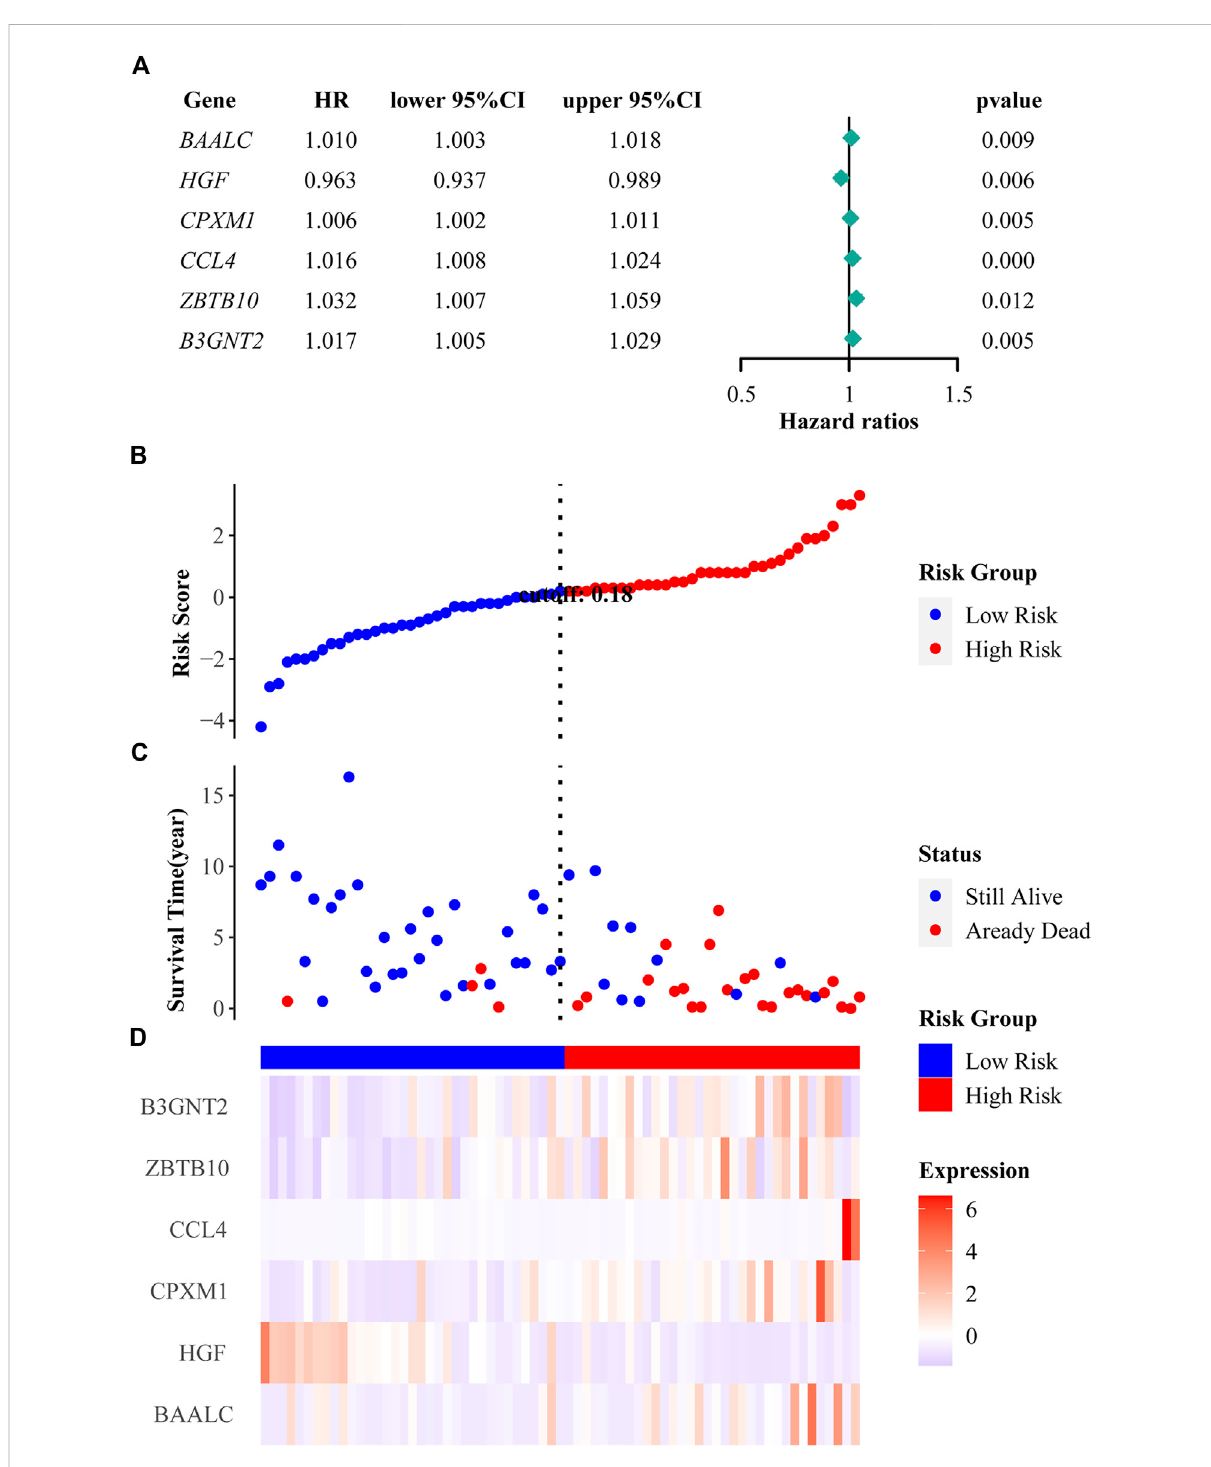
FIGURE 5 Regression analysis and characteristics of prognostic gene signatures. (A) Forest map of six prognostic genes by univariate cox regression. (B) Distributions of risk scores in all samples. (C) Distribution of follow-up times in the training samples. (D) Heat map of gene expression in the prognostic signature of